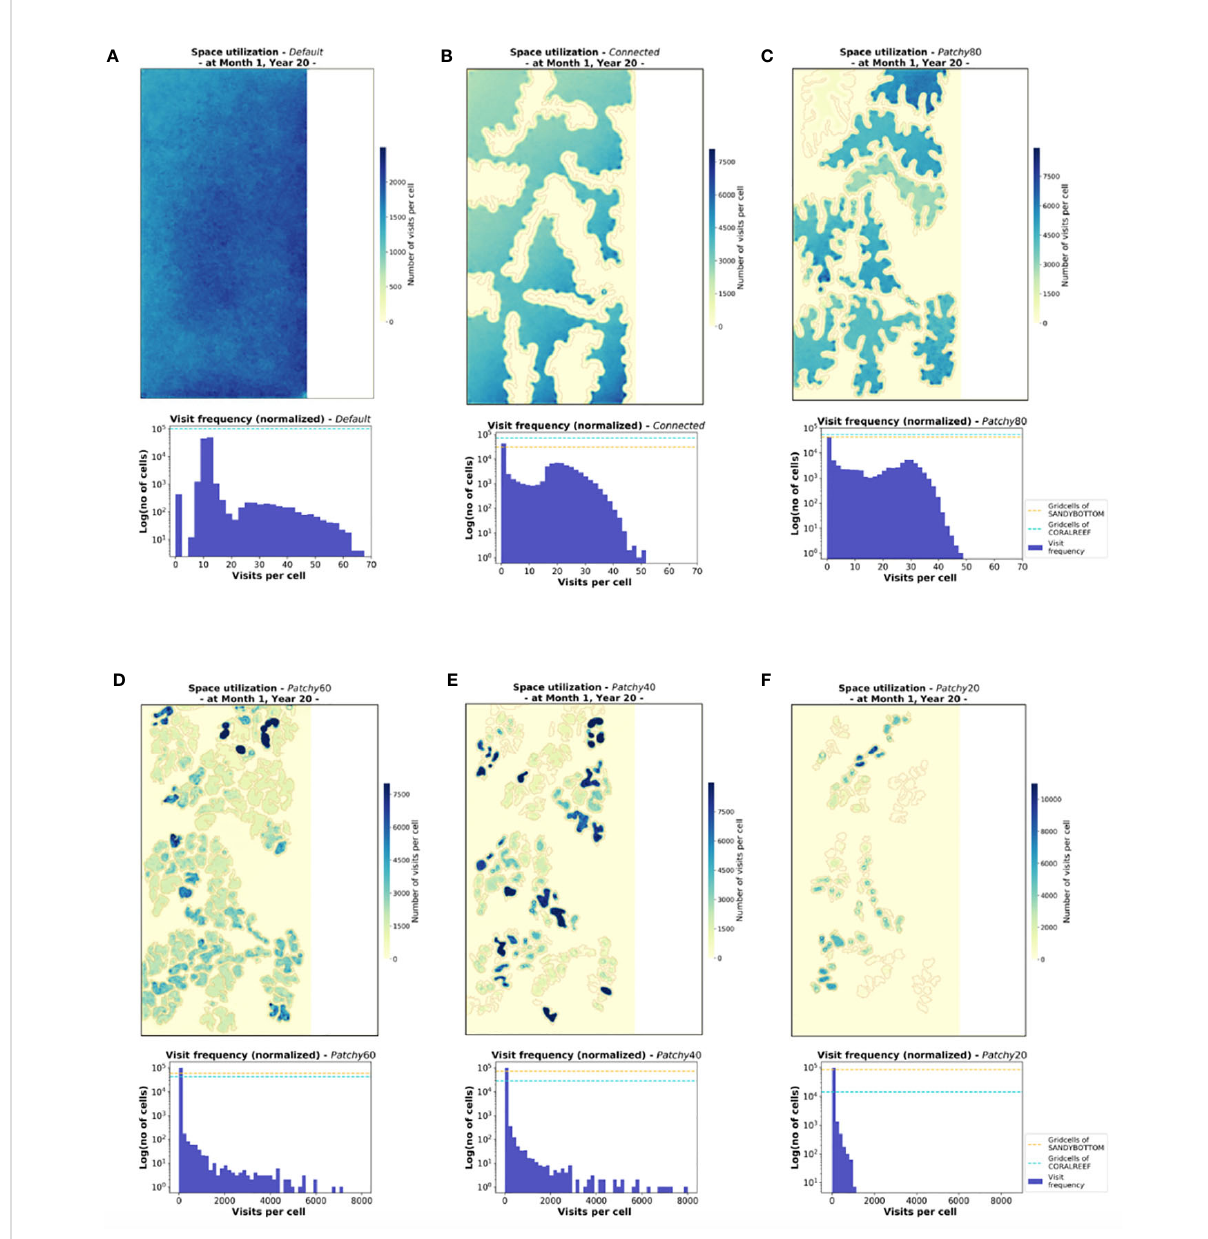
FIGURE 7 Cumulated visits of fi shes to each habitat cell illustrating the monthly space use patterns on the population level for the six different scenarios (A-F) . Shown are heatmaps and histograms of visit frequency per grid cell (normalized for one fi sh), both based on representative data of Month 1 at Year 20 of the simulation period. The underlying patches of coral reef habitat are outlined in light grey, gird cells of type MAINLAND are indicated in white (heatmaps). Histograms display visit frequency to the habitat cells CORALREEF and SANDYBOTTOM (without MAINLAND cells) and proportions of the two habitat types are indicated by dashes